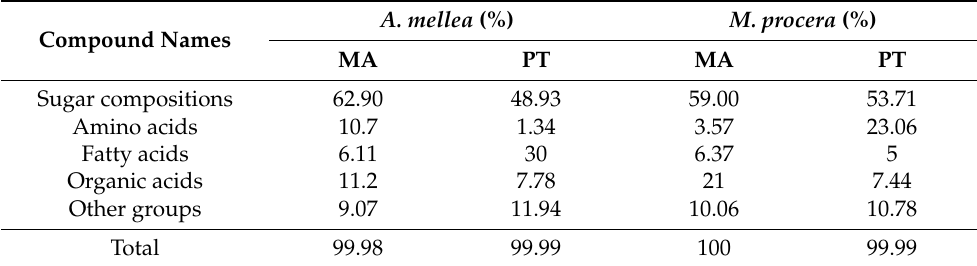
Table 3. Biomolecules groups of methanolic extracts analysis by